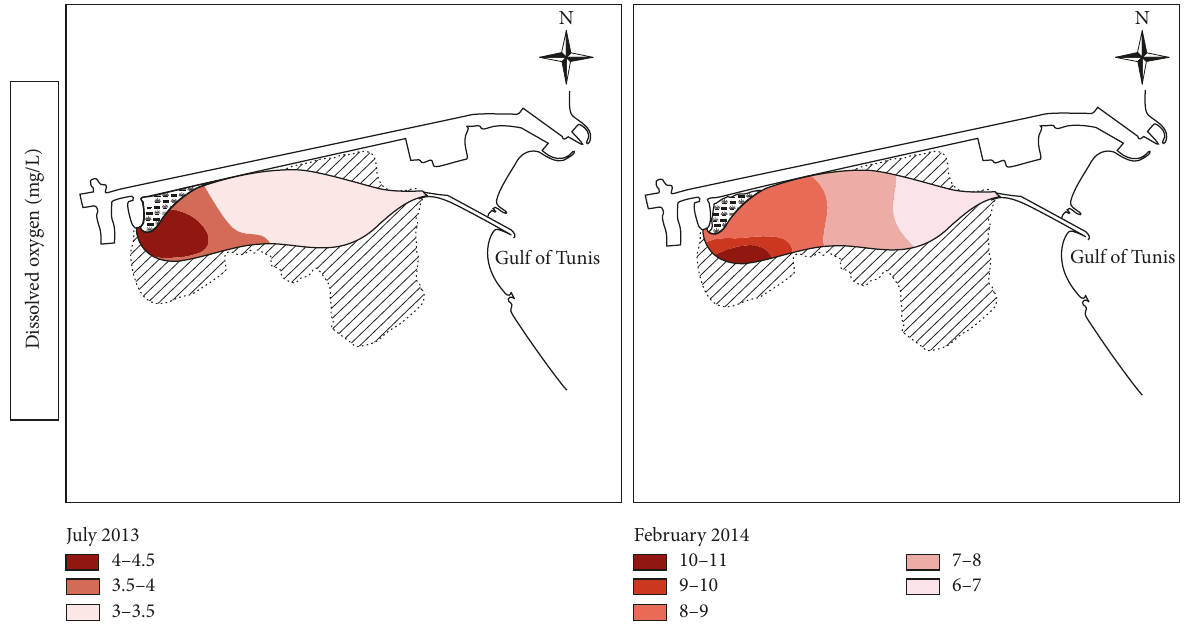
Figure 5: Dissolved oxygen distribution map of the South Lagoon of Tunis.